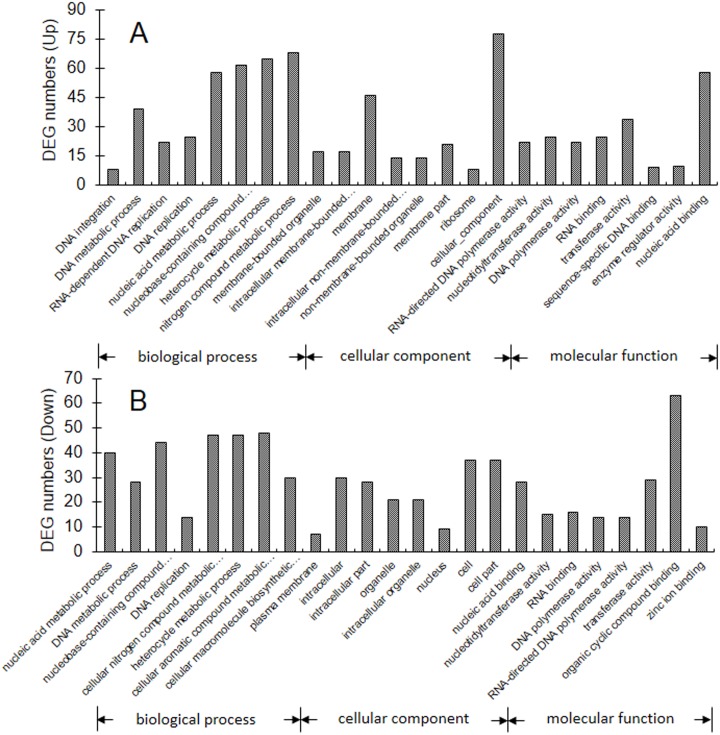
Histograms showing GO functional analysis of the up-regulated (A) and down-regulated (B) common DEGs.The x-axis indicates the names of the eight most abundant classes in each of the three main GO categories. The y-axis indicates the numbers of common DEGs.